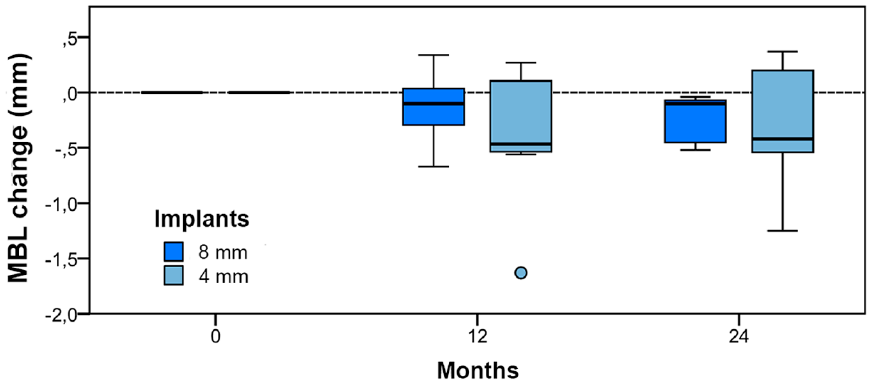
Figure 9 Bone tissue remodeling value distribution by stage and implant type. Figure 9. Bone tissue remodeling value distribution by stage and implant